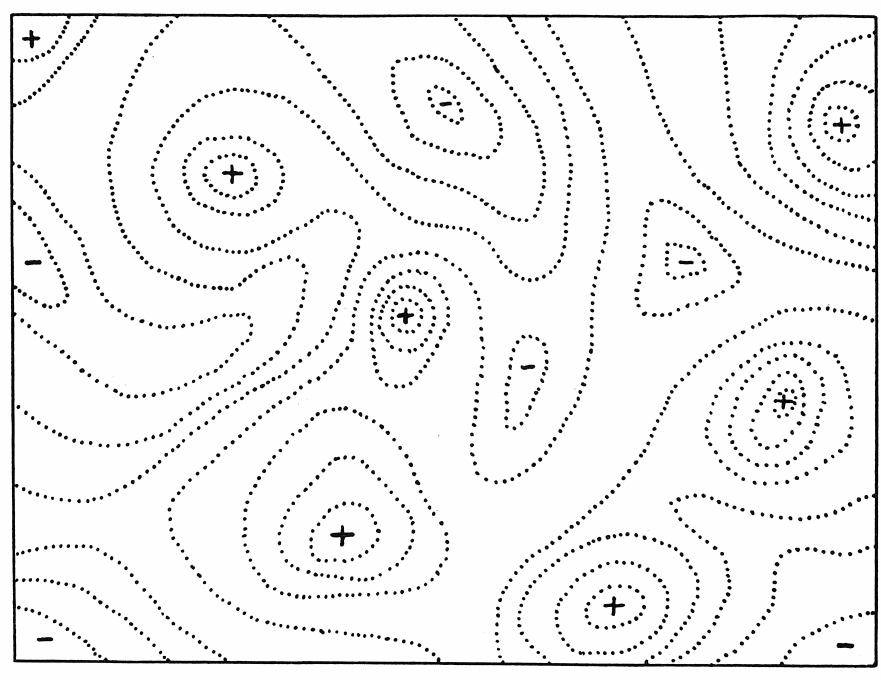
The Adaptive Landscape , from Sewall Wright, "Evolution in Mendelian populations," Genetics 16 (1931), 358 (photo: